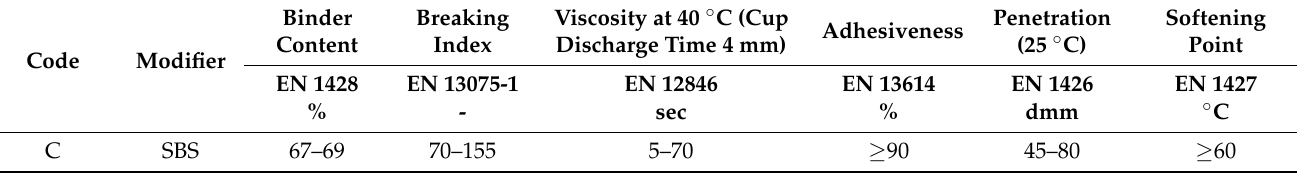
Table A6. Emulsion typical